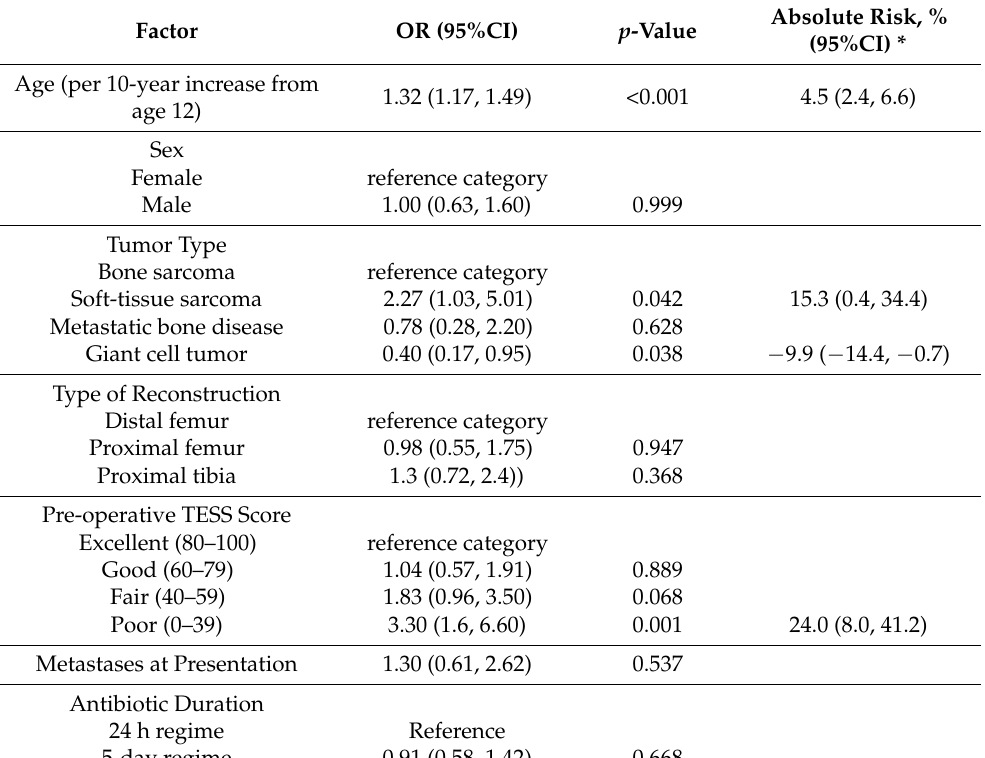
Table 4. Binomial logistic regression analysis evaluating factors associated with failure to achieve excellent post-operative function at 1 year (n =